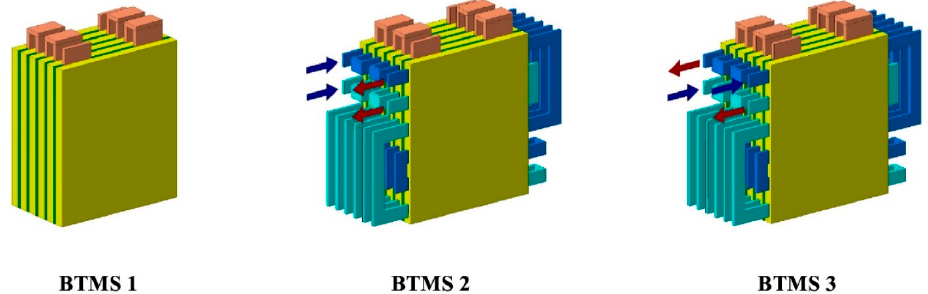
Figure 28. BTMS 1—passive, PCM only; BTMS 2—active cooling, parallel flow; BTMS 3—active cooling, counter flow. Reproduced from [103] with permission from Elsevier.